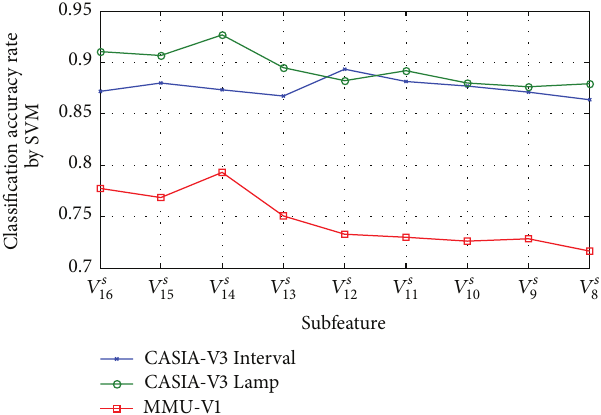
Figure16:Classificationaccuracyofsubfeaturebasedonmagnitude selection by SVM